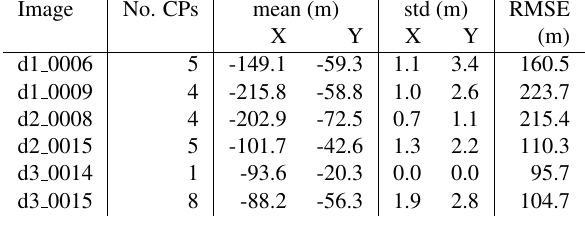
Planimetric checkpoint errors against Open-